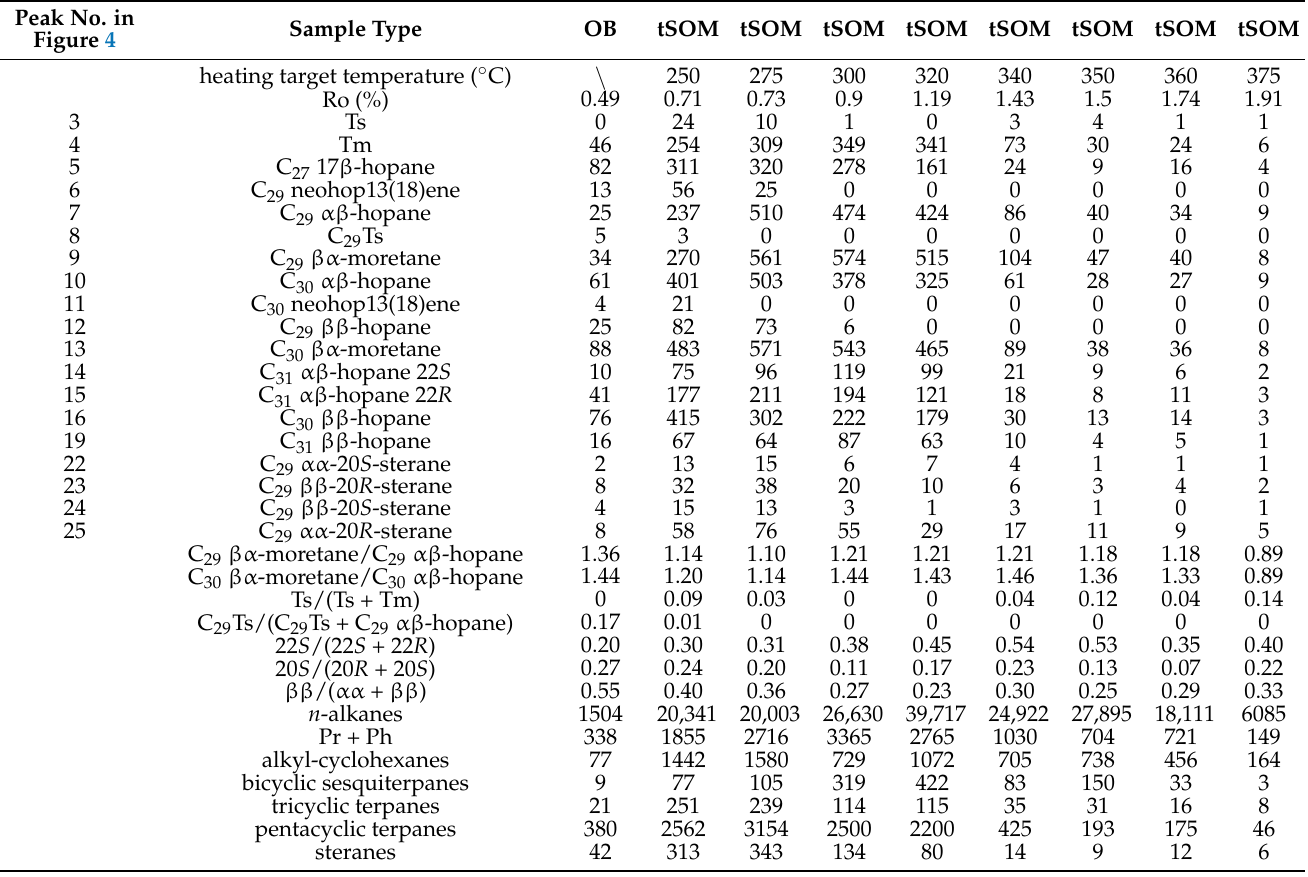
Table 1. Changes in investigated isomer concentrations ( µ g/g tSOM), compound class concentrations ( µ g/g tSOM) and biomarker ratios in the OB and the tSOMs (own